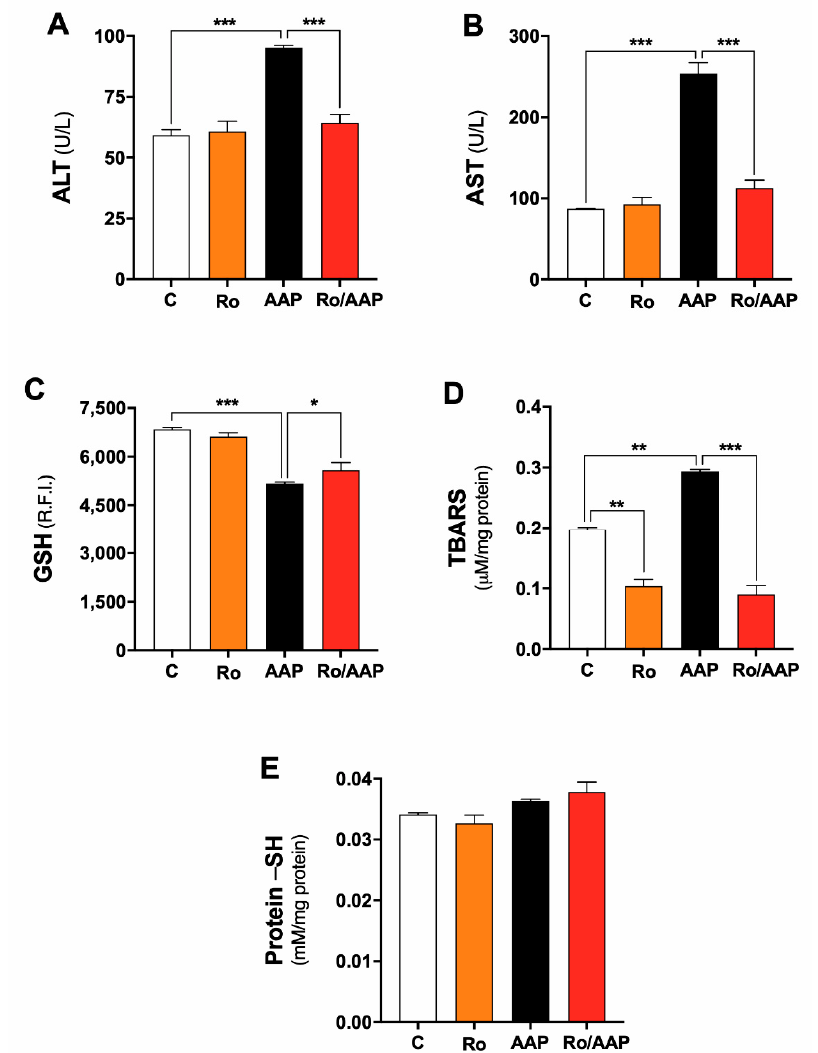
Figure 4. Rosmarinus officinalis ( Ro ) protects against acetaminophen-induced hepatotoxicity in vivo. Rats were divided into four groups (n = 7) and treated intraperitoneally, as described in Materials and Methods. Group C (white bars): control, treated with vehicle (DMSO); group Ro (orange bars): 0.5% Ro once a day for four days; group AAP (black bars): single dose of 900 mg/kg acetaminophen; group Ro/AAP (red bars): received Ro for four days, followed by single dose of AAP. ( A ) Alanine aminotransferase and ( B ) aspartate aminotransferase levels. ( C ) GSH, ( D ) TBARS, and ( E ) reduced thiol groups of proteins quantified as described by isolated mitochondria in Figure 1. Statistical differences are indicated by * ( p < 0.05), ** ( p < 0.01), and *** ( p <